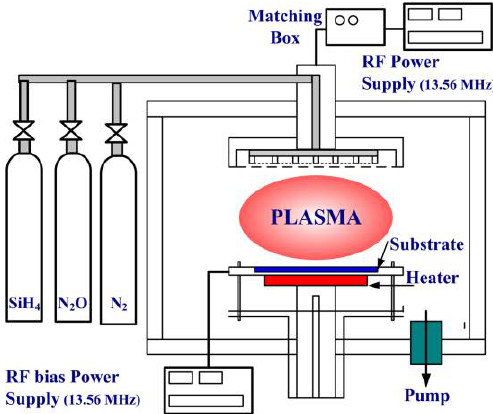
Figure 2. A schematic diagram of the RF PECVD